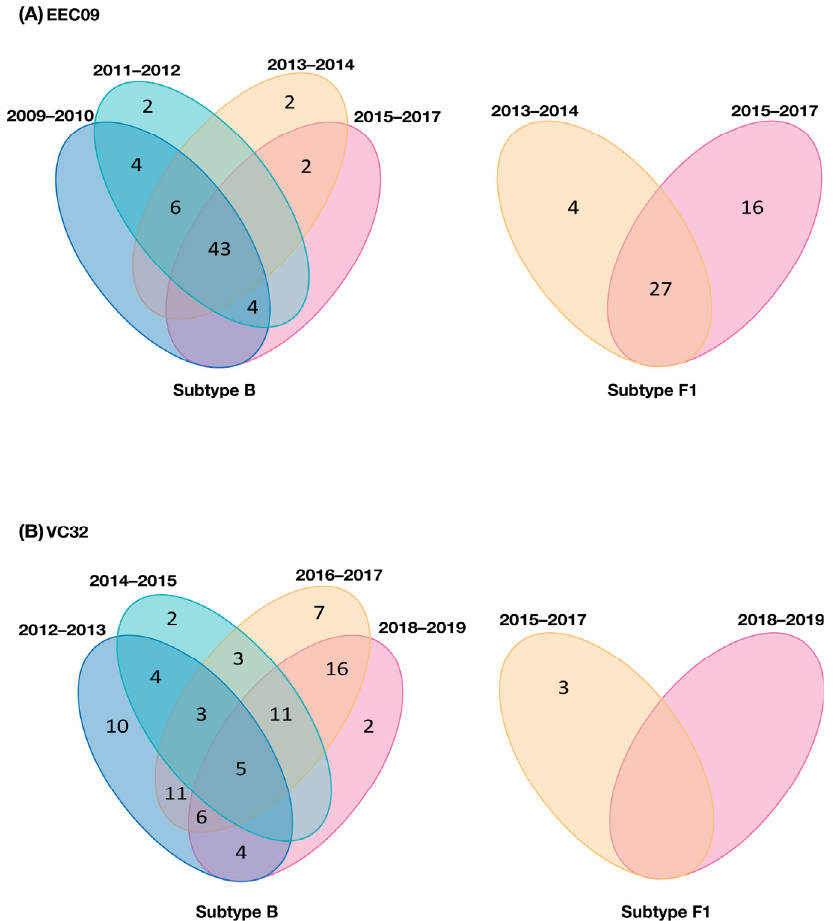
Figure 4. Number and temporal overlap of identical HIV-1 sequences (proviral clones) in subjects EEC09 ( A ) and VC32 ( B ). Venn diagrams contain the total number of identical proviral sequences, i.e., sequences that occurred more than once within the same participant, detected within subtypes B and F1 quasispecies at one (non-overlapping regions) or several (overlapping regions) time intervals during follow-up.